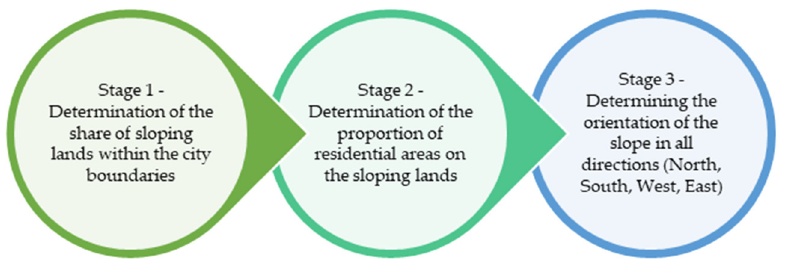
Figure 1. Research